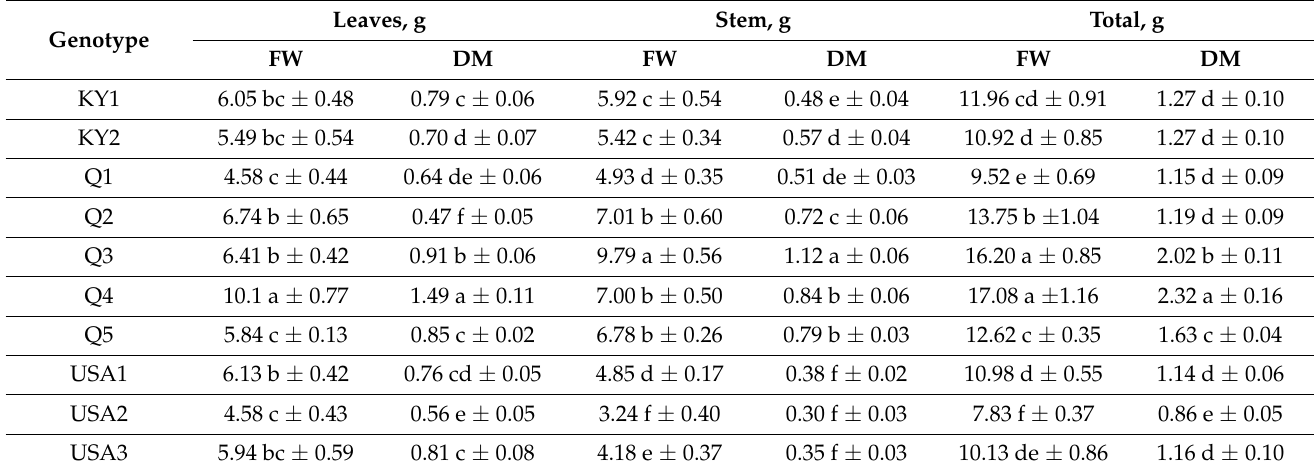
Table 2. Fresh weight (FW) and dry matter (DM) of the middle parts of quinoa genotypes.